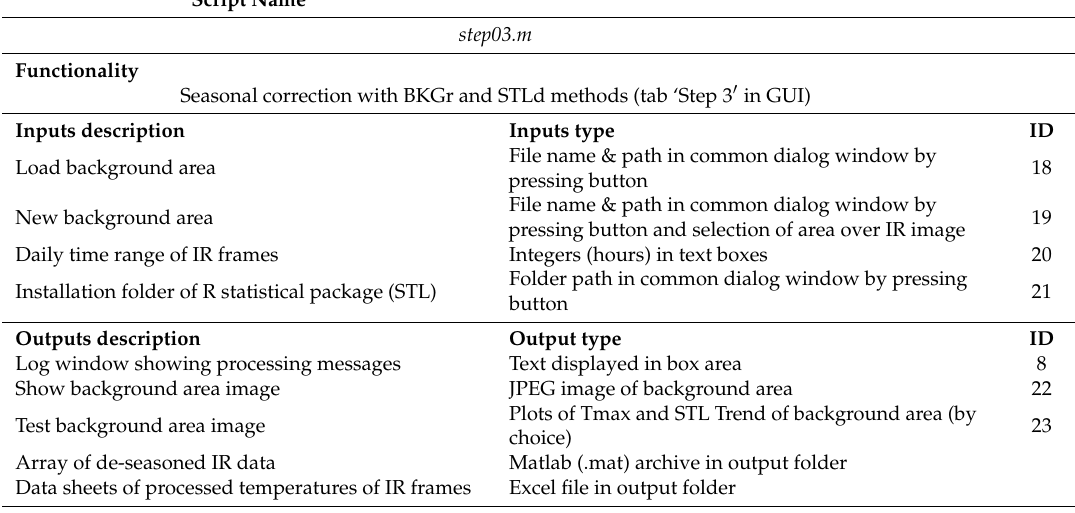
Table A4. Technical specifications of functionality and input/output data type of STEP 3.